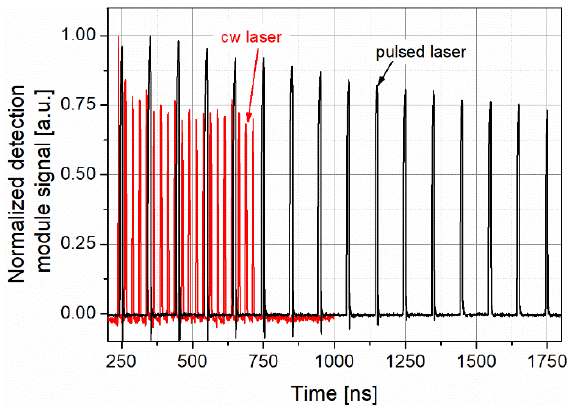
Figure 12. Registered pulses for BURST (16 triggering pulses with a repetition rate up to a frequency of 2.5 MHz (pulsed) and 40 MHz (cw)) mode operation of pulsed and cw lasers.